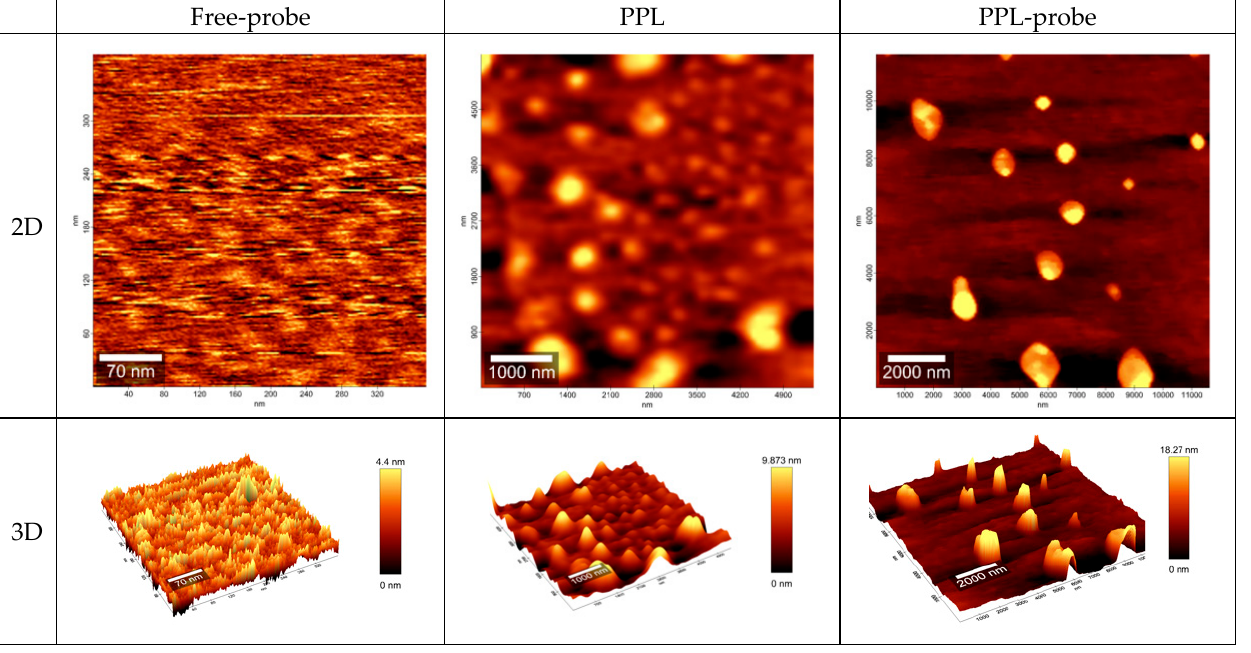
Figure 3. AFM images for topology in nm for two-dimensional (2D) and three-dimensional (3D) representation for free-probe, free-PPL, and PPL-probe. Note the well-marked spheres in PPL and PPL-probe.